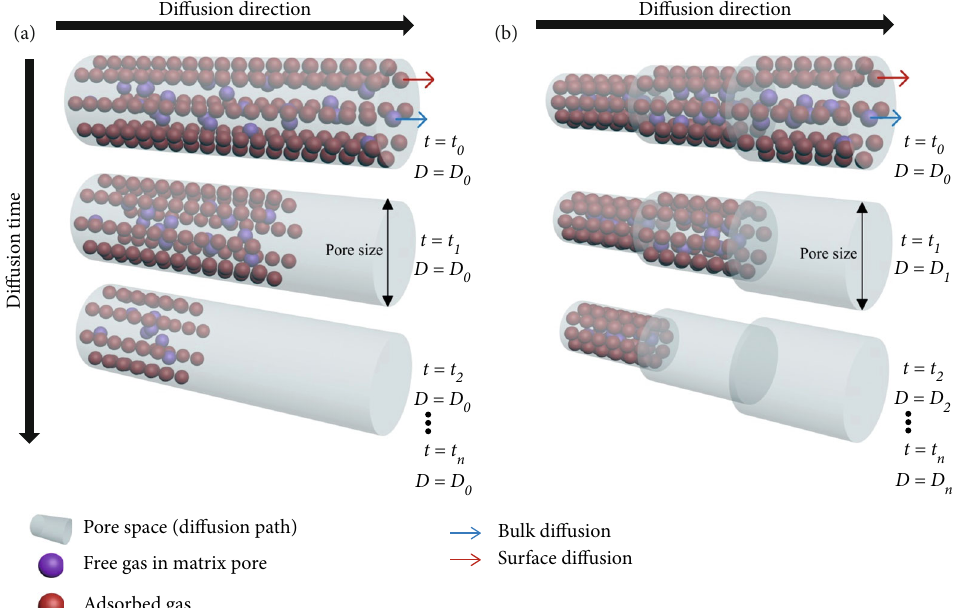
Figure 2: Gas di ff usion in (a) unipore model and (b) multistage pore model during long-term gas production.